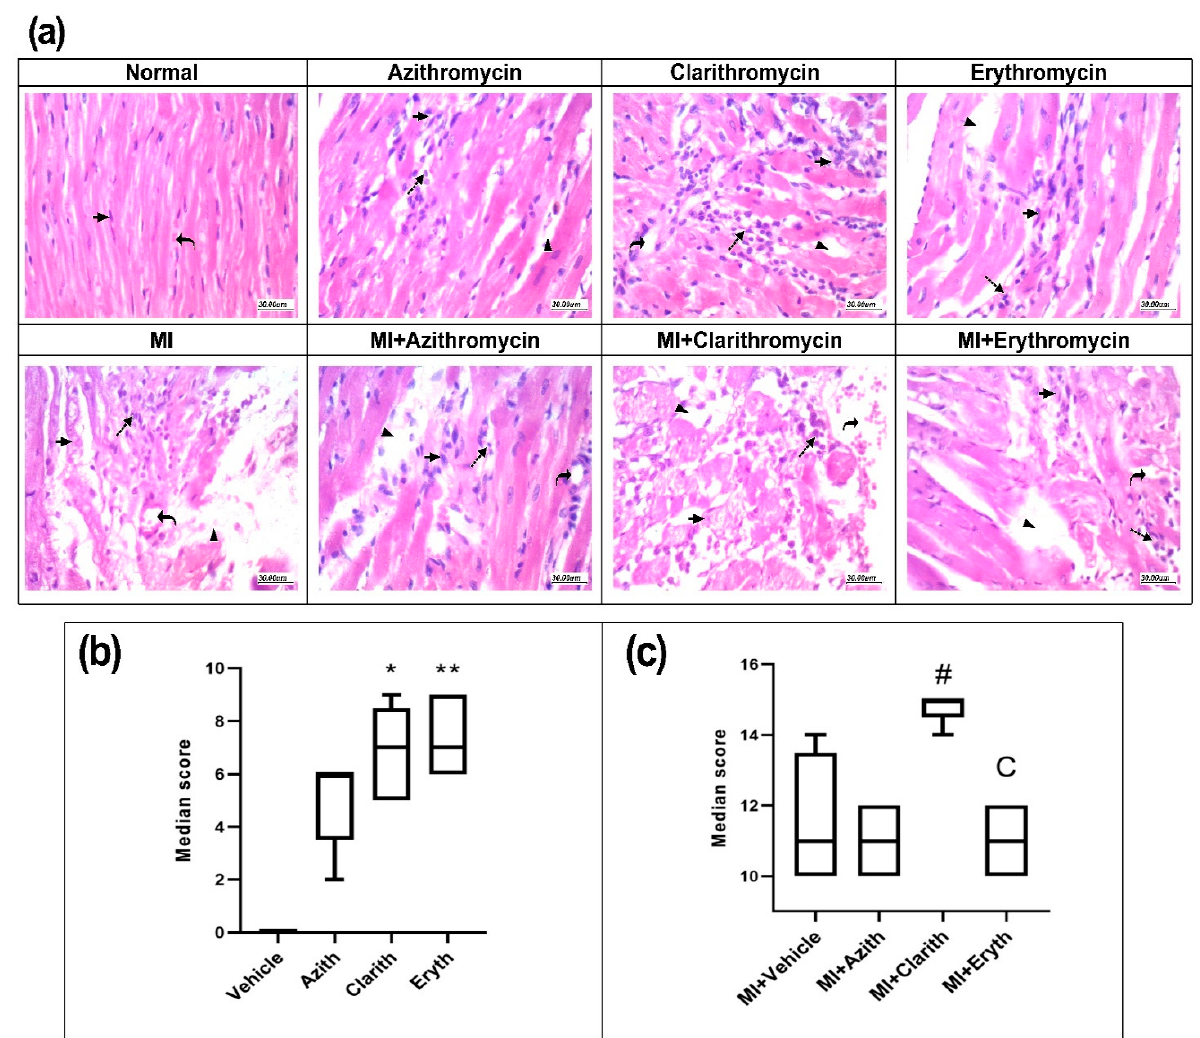
Figure 4. Hematoxylin and eosin staining for cardiac specimens in the two rat experiments. ( a ) Images for specimens were taken from healthy or MI rats treated with azithromycin (Azith), clarithromycin (Clarith), or erythromycin (Eryth). ( b ) Histologic scores for healthy rat experiment and ( c ) Histologic scores for MI rat experiment. MI: myocardial infarction. Data presented as medians, and interquartile ranges for the histologic score in each set, were analyzed separately by Kruskal-Wallis ANOVA and Dunn’s Test. * p -value less than 0.05, ** p -value less than 0.01 different from the vehicle group. # p -value less than 0.05: different from the azithromycin group of the same experiment. C p -value less than 0.05: different from the MI + Clarith group ( n = 4–6).